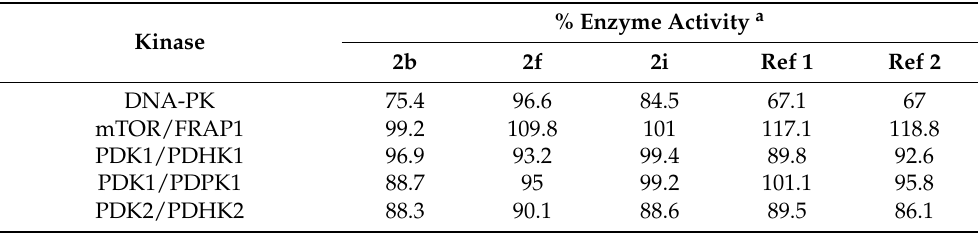
Table 2. Kinase profile of 2-arylmethyl-1-oxo-1,2,3,4-tetrahydropyrazino[1,2- a ]indole-3-carboxamide analogs over a panel of 18 kinases (DNA-PK, mTOR, 5 PDKs, TBK1, and 10 PI3Ks). % Enzyme Activity a Kinase 2b 2f 2i Ref 1 Ref 2 DNA-PK 75.4 mTOR/FRAP1 99.2 PDK1/PDHK1 PDK2/PDHK2